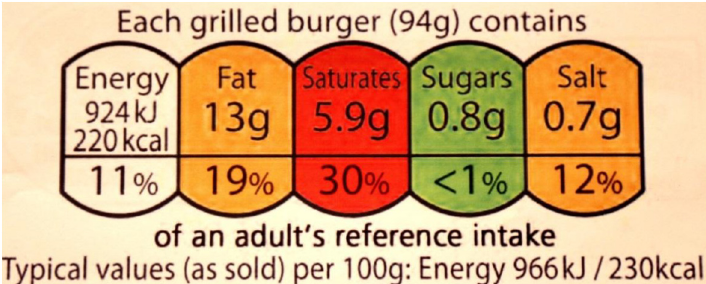
Figure 2. The voluntary, hybrid, front-of-pack nutrition label incorporating percentage reference intakes (daily guideline amounts) with color coding (United Kingdom).